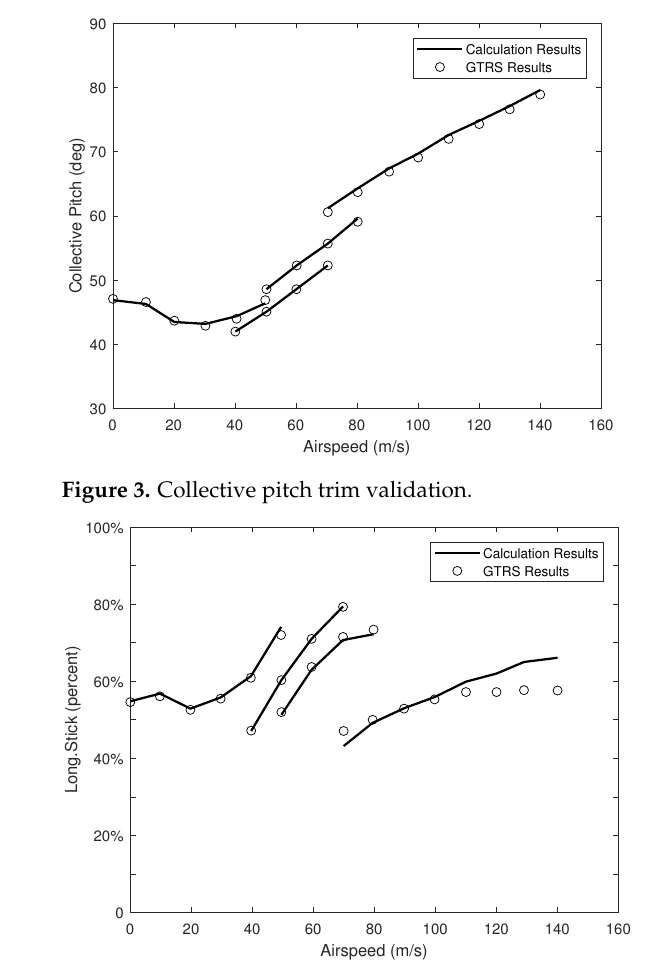
Figure 4. Longitudinal stick trim validation.